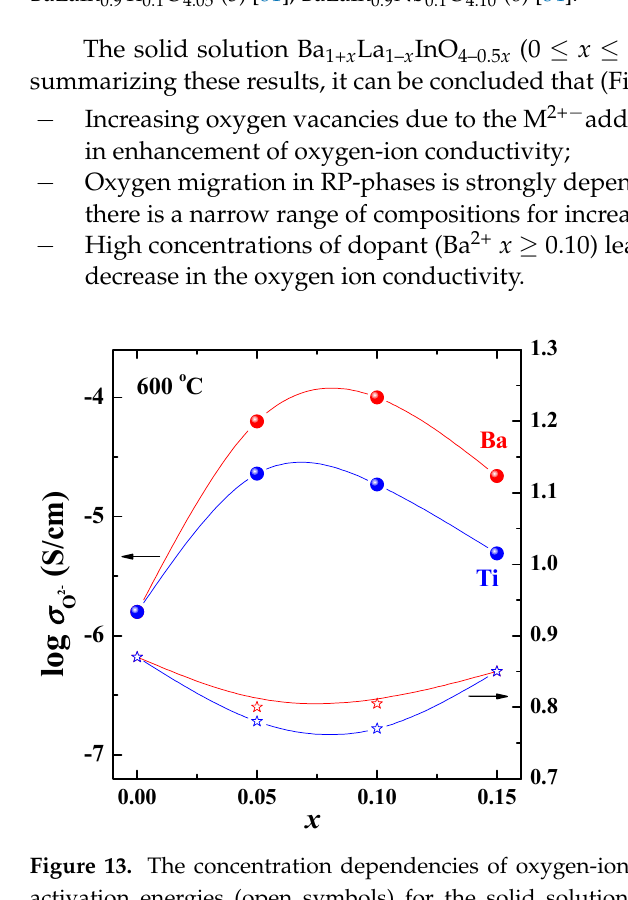
Figure 14. The concentration dependencies of oxygen-ionic transport numbers for the solid solution Ba 1+ x La 1 − x InO 4 − 0.5 x (red) [79] at 600 °C and for the solid solution BaLaIn 1 − x Ti x O 4+0.5 x (blue) [80] at 300 and 600 °C. 4.5.2. Effect of Substitutions on the B-Sites The solid solution BaLaIn 1– х Ti х O 4+0.5 х (0 ≤ x ≤ 0.15) was investigated in [80]. The intro- duction of ions with a smaller ionic radius ( 𝑟 (cid:2904)(cid:2919) (cid:3120)(cid:3126) = 0.605 Å, 𝑟 (cid:2893)(cid:2924) (cid:3119)(cid:3126) = 0.80 Å [87]) should lead to a decrease of cell parameters, however, decreasing was observed for c -parameter, but a and b -parameters as well as unit cell volume increased with dopant concentration. The observed increase in a and b -parameters and cell volume may be a consequence of the incorporation of the oxygen interstitials in the rock-salt layers. The Ti 4+ -doping of BaLaInO 4 led to the increase in the O 2 − -conductivities up to ~1–1.5 orders of magnitude. The concentration dependencies of the oxygen-ionic conductivity